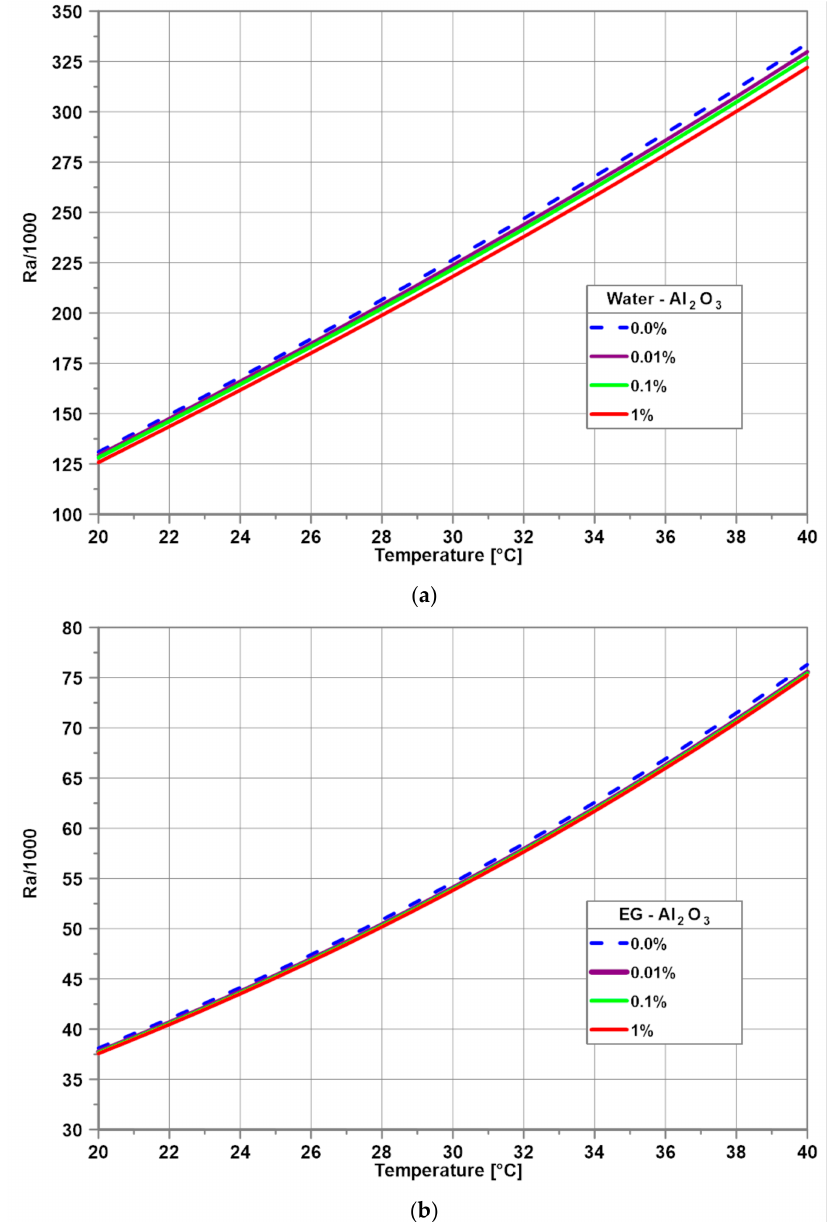
Figure 8. Variation of Rayleigh number with temperature for water-based ( a ) and EG-based ( b )